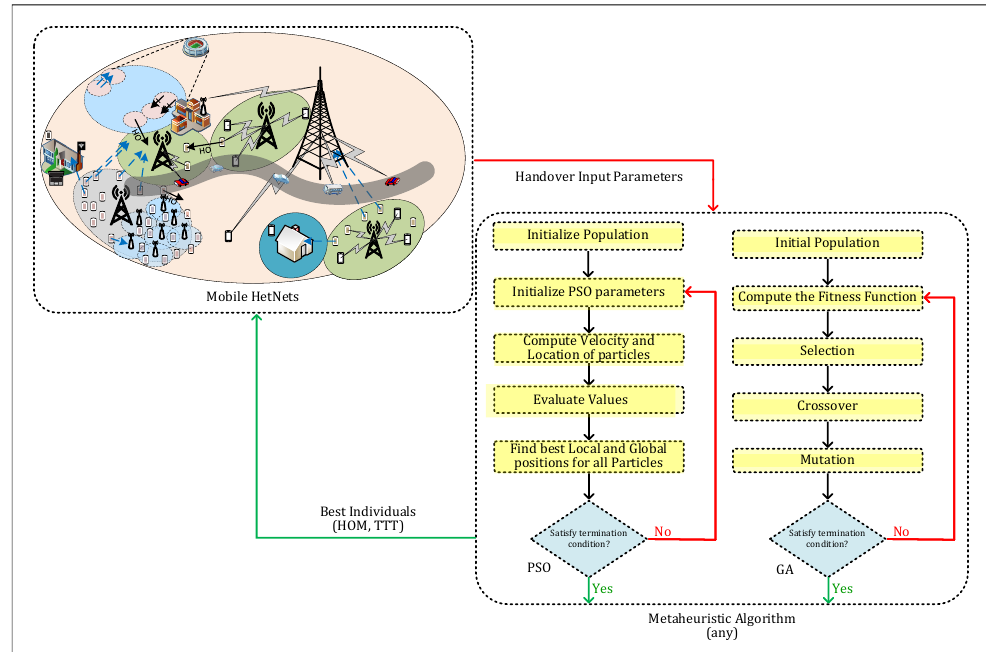
Figure 9. Schemetic Diagram of Metaheuristic-based Handovers in